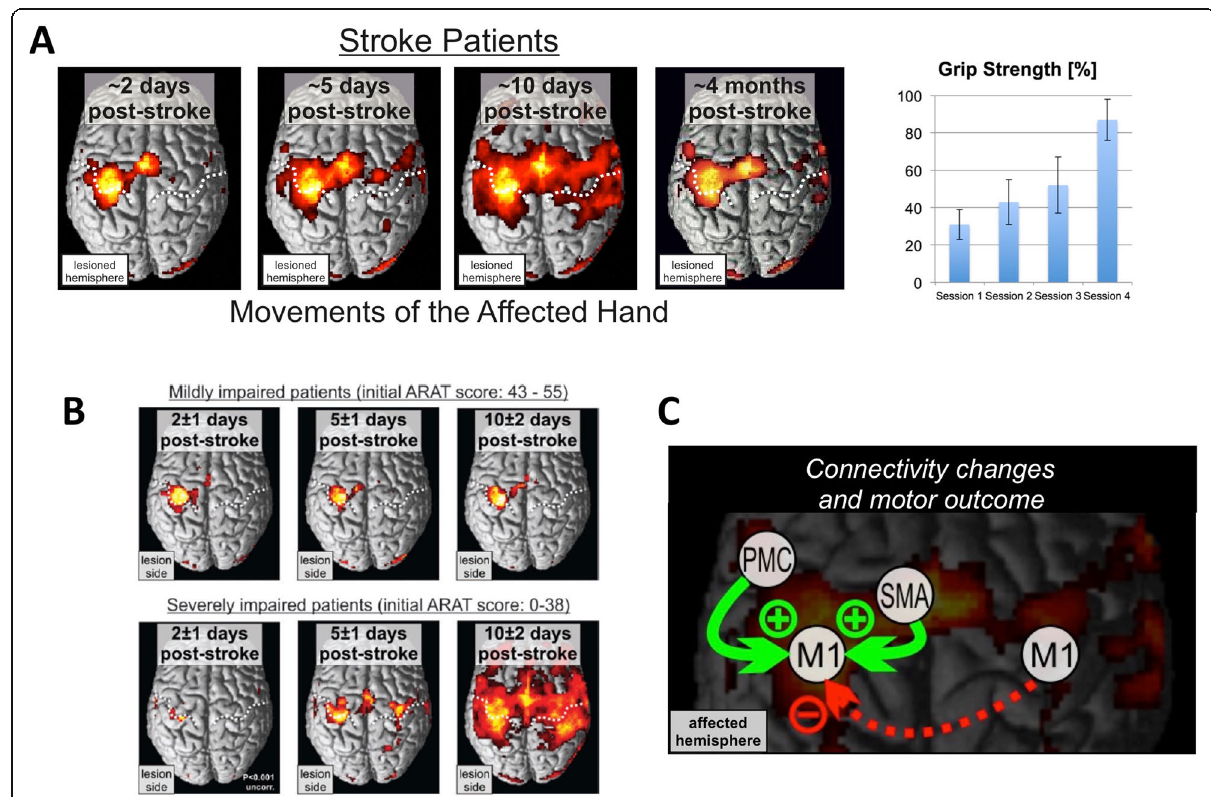
Fig. 3 Neuroimaging of motor network reorganization after a first-ever stroke. a fMRI activity maps associated with movements of the paretic hand at different time points post-stroke. Recovery of hand motor function (here: maximum grip strength) is associated with fMRI signal increases early after stroke, the latter returning to levels observed in healthy controls with good functional recovery. From Rehme et al. [52, 53], with permission. b Impact of motor impairment and activity changes post-stroke. From Rehme et al. [52, 53], with permission. c Connectivity changes correlated with motor outcome. Green arrows: Increases indicate good functional motor outcome. Red arrow: Patients developing inhibitory influence from contralesional upon ipsilesional M1 activity feature poor functional motor